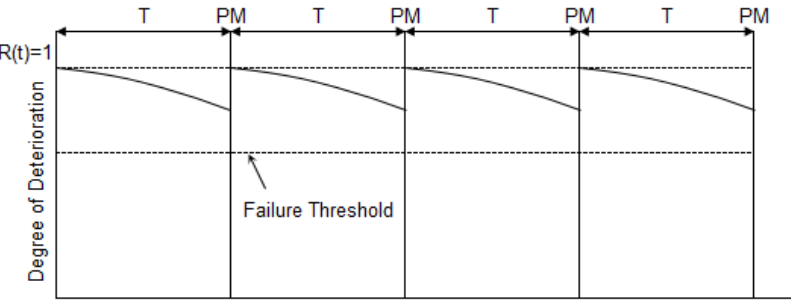
Fig. 1. Relationship between Reliability Deterioration and Preventive